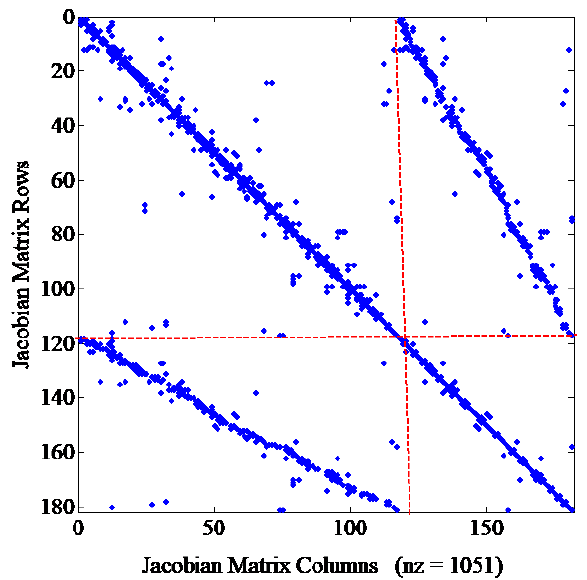
Figure 13. The sparsity form of the Jacobian matrix at a load level of 2.75.